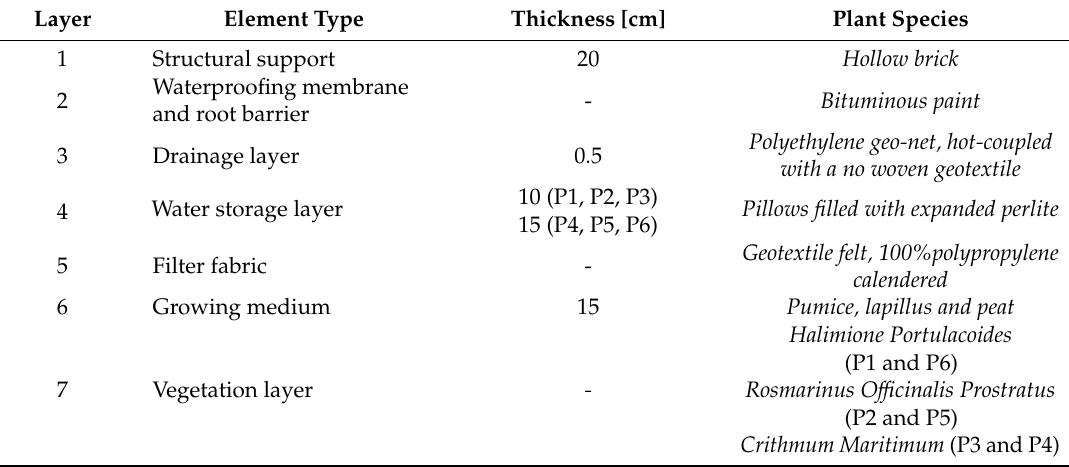
Table 1. Description of the layers constituting the green roof